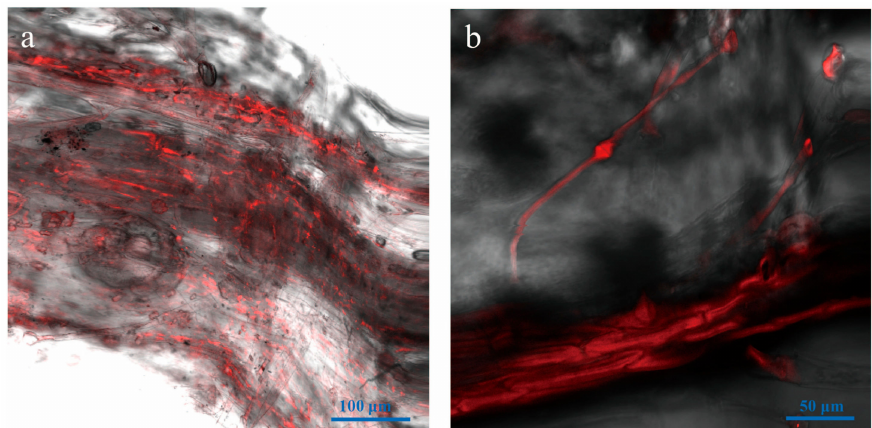
Figure 7. LSCM of hyphal colonization in leaves at ten days after inoculation of roots of N. benthamiana with Vd-m . ( a ) Leaf petiole and ( b ) veins.